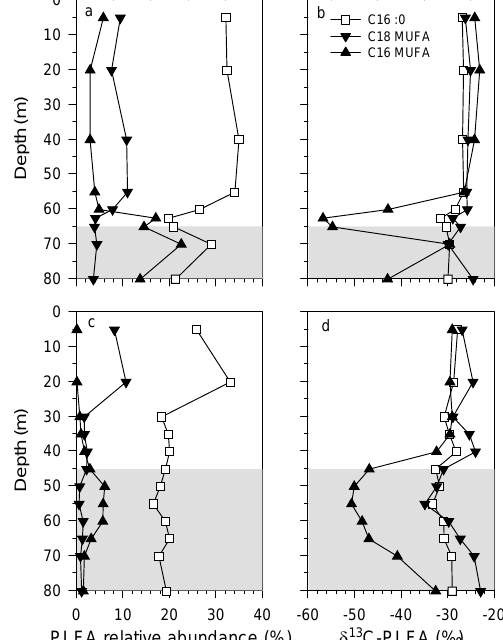
Figure 3. Vertical profiles of the relative abundance of phospho- lipid fatty acids (PLFAs, %) and their respective carbon isotopic signature ( δ 13 C-PLFAs,‰) in (a, b) the southern basin in Septem- ber 2012 (dry season) and (c, d) in the northern basin in February 2012. Error bars representing standard deviation of replicates were smaller than the data point size. The grey zone corresponds to wa- ters with dissolved O 2 concentration <3µmolL − 1 .